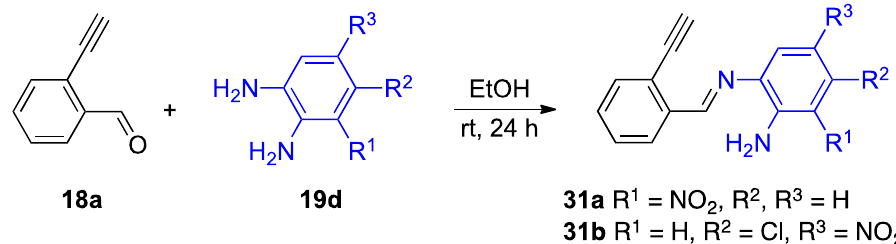
Figure 21. Isolation of mechanistically relevant imine intermediates 31a , b .